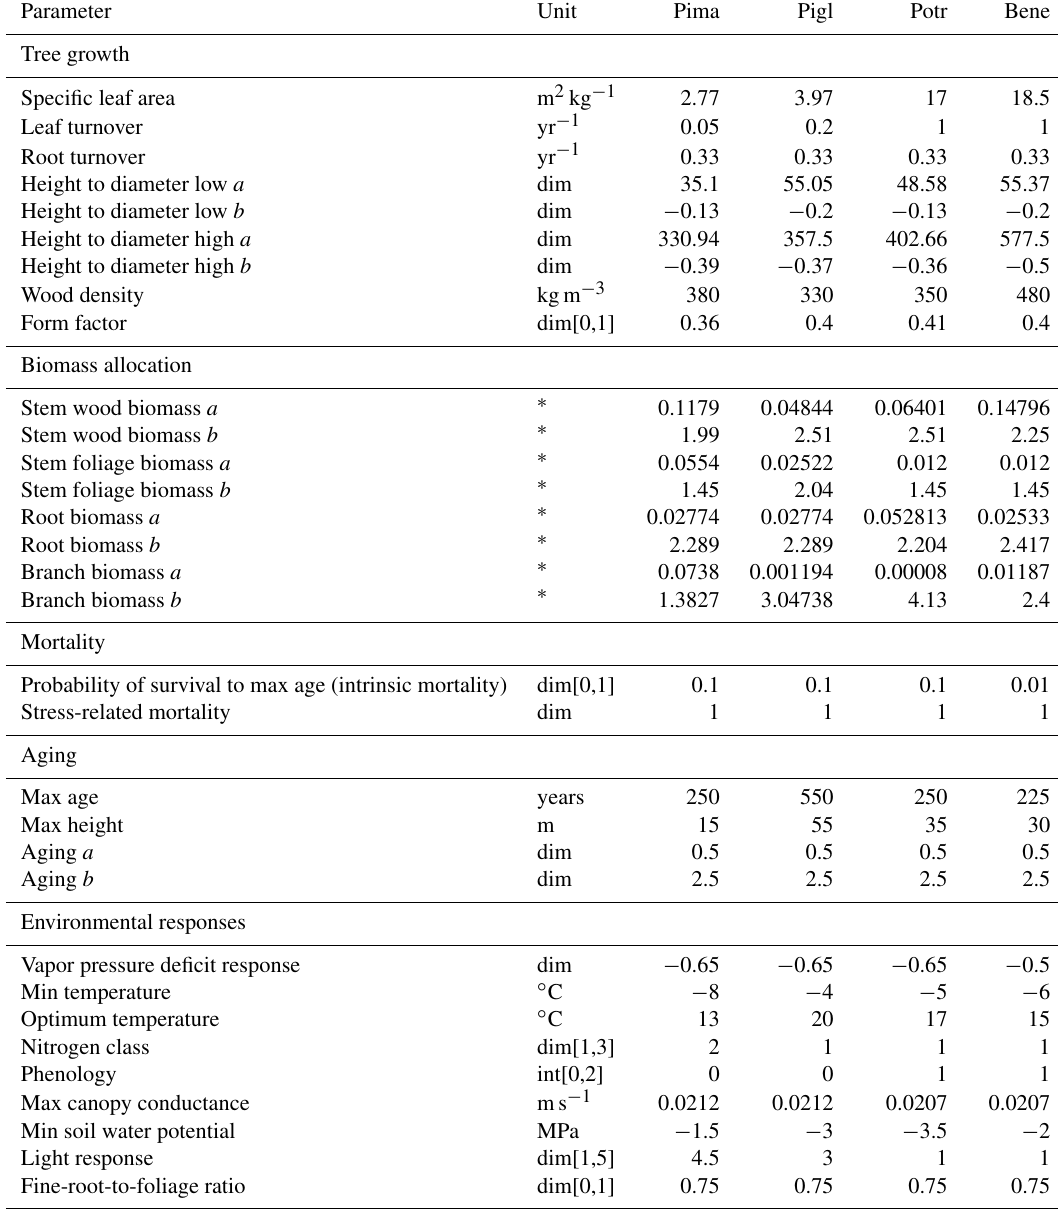
Table B1. Species parameters for interior Alaskan boreal forest. Pima: Picea mariana (black spruce); Pigl: Picea glauca (white spruce); Potr: Populus tremuloides (trembling aspen); Bene: Betula neoalaskana (Alaskan birch); dim: dimensionless; exp: expression; sdlings: seedlings. See Hansen et al. (2021) for